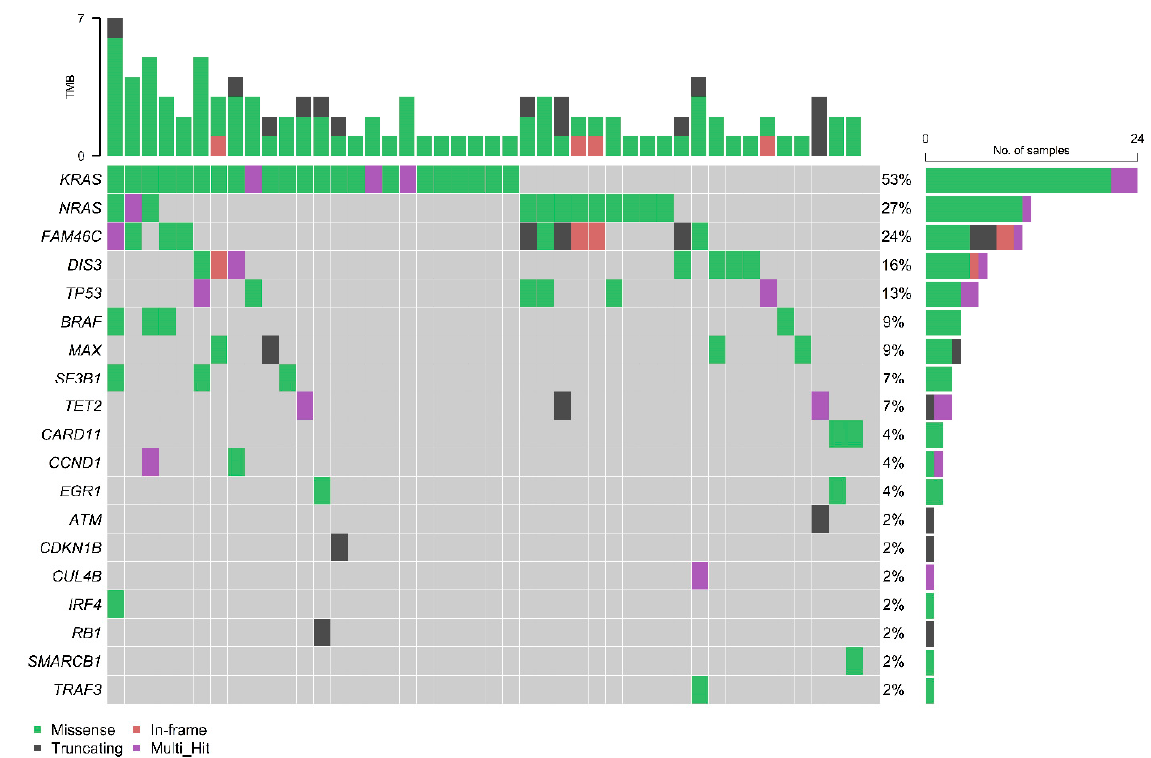
Figure 2. Oncoplot of altered genes in sorted CD138 + myeloma cells in patients with relapsed or refractory multiple myeloma. The target NGS analysis was performed on 45 patients.